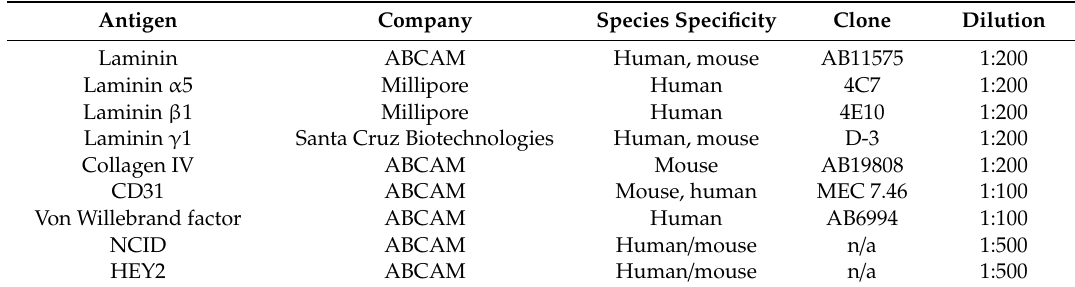
Table 1. Immunohistochemistry / Immunocytochemistry